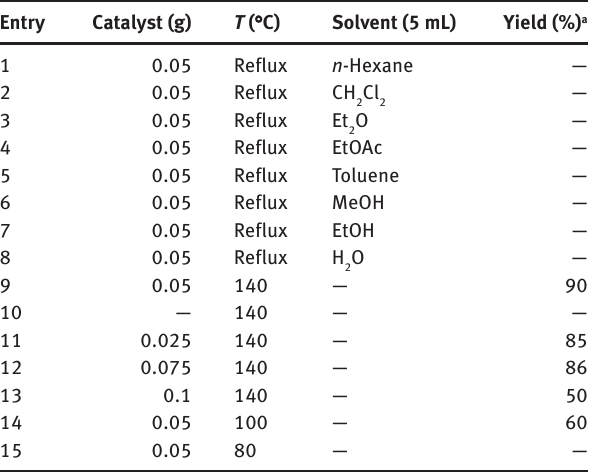
Table 1: Optimization of the reaction condition for the synthesis of thieno[2,3- d ]pyrimidin-4(3 H )-ones.